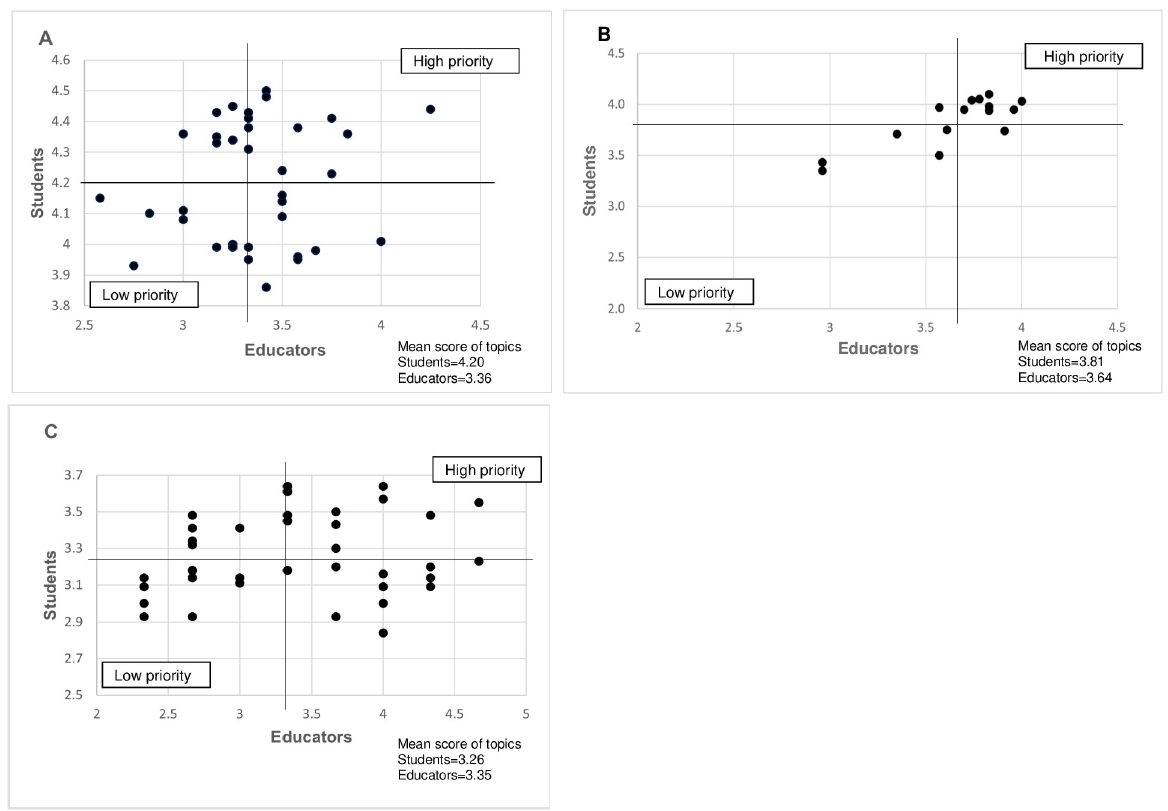
Fig 3. Comparison of the mean score of each topic given by the students and educators in Round 2. (A) University of Malaya (B) Universiti Putra Malaysia (C) Taylor’s University. A scatter plot was used to harmonise the topics prioritisation between students and educators by comparing the mean score of each topic in Round 2 (X-axis is the mean score of each topic by educators, Y-axis is the mean score of each topic by students). The lines represent the mean score of the topics.